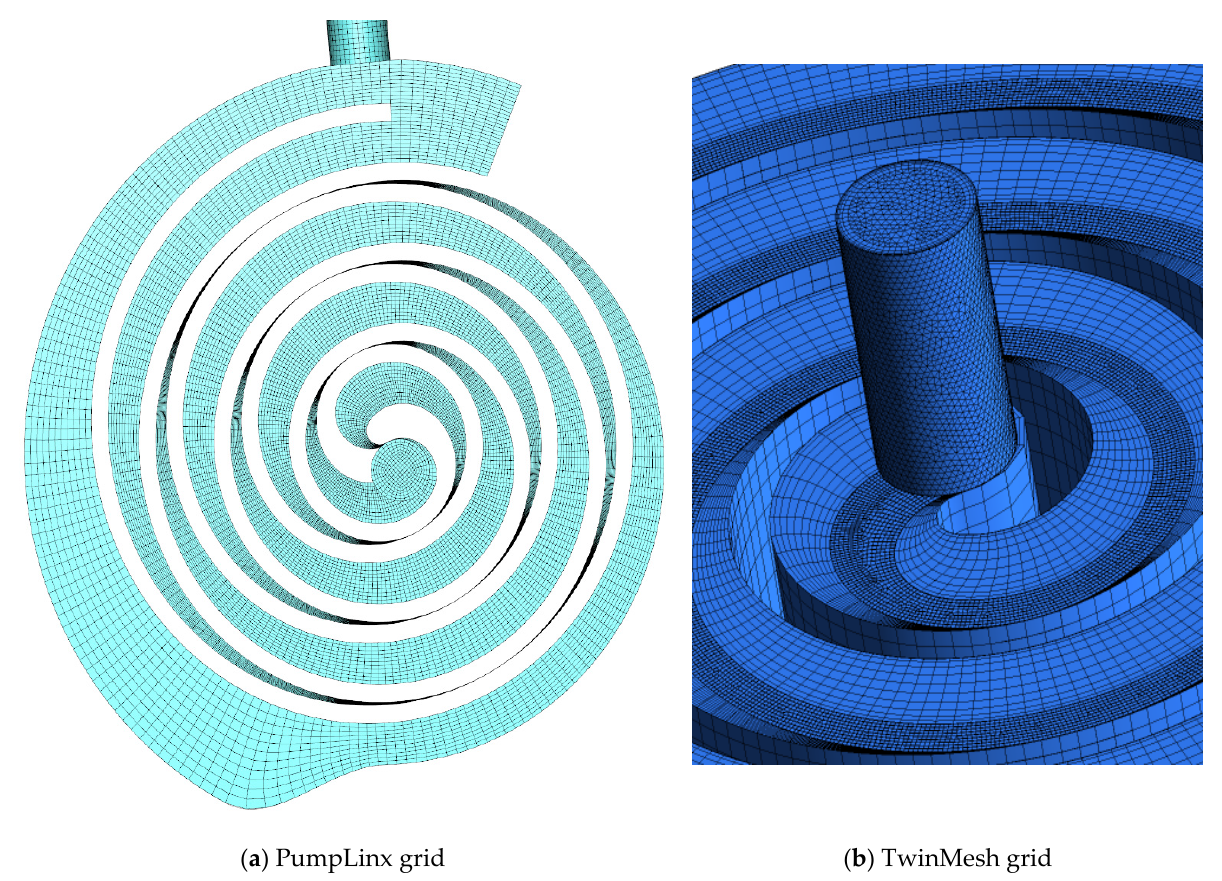
Figure 6. Overview of the PumpLinx grid ( a ) and detail of the TwinMesh grid at the discharge in case of the model with axial gap.